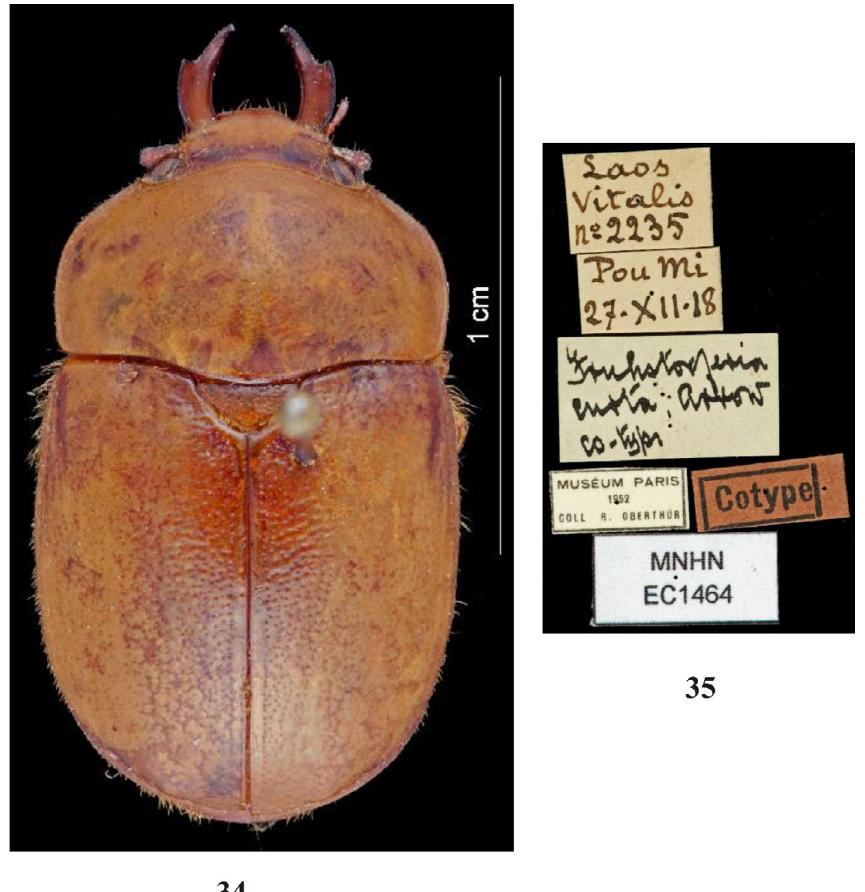
[Source: Muséum national d’Histoire naturelle, Paris (France). Collection: Insects-Coleoptera (EC) Specimen